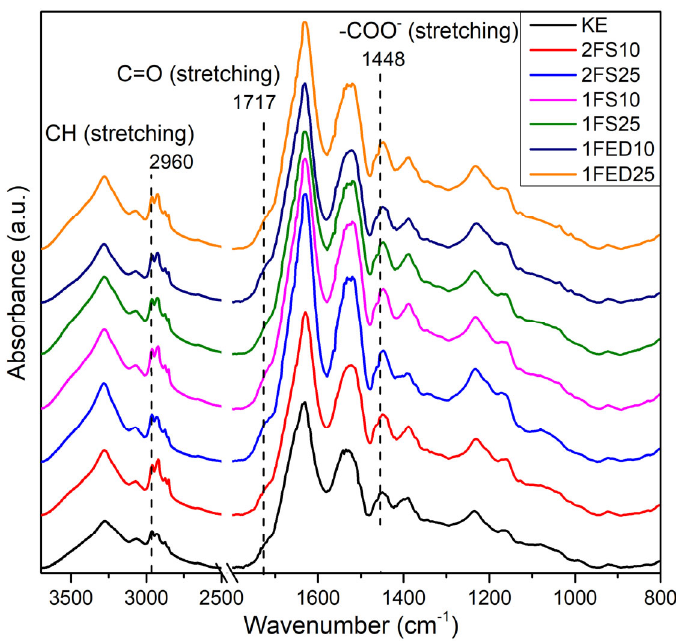
Figure 6. FTIR profiles of keratin (KE) and keratin functionalized in one (1) ‐ or two (2) ‐ stages, with SA (S) or EDTAD (ED) at 10% and 25%.